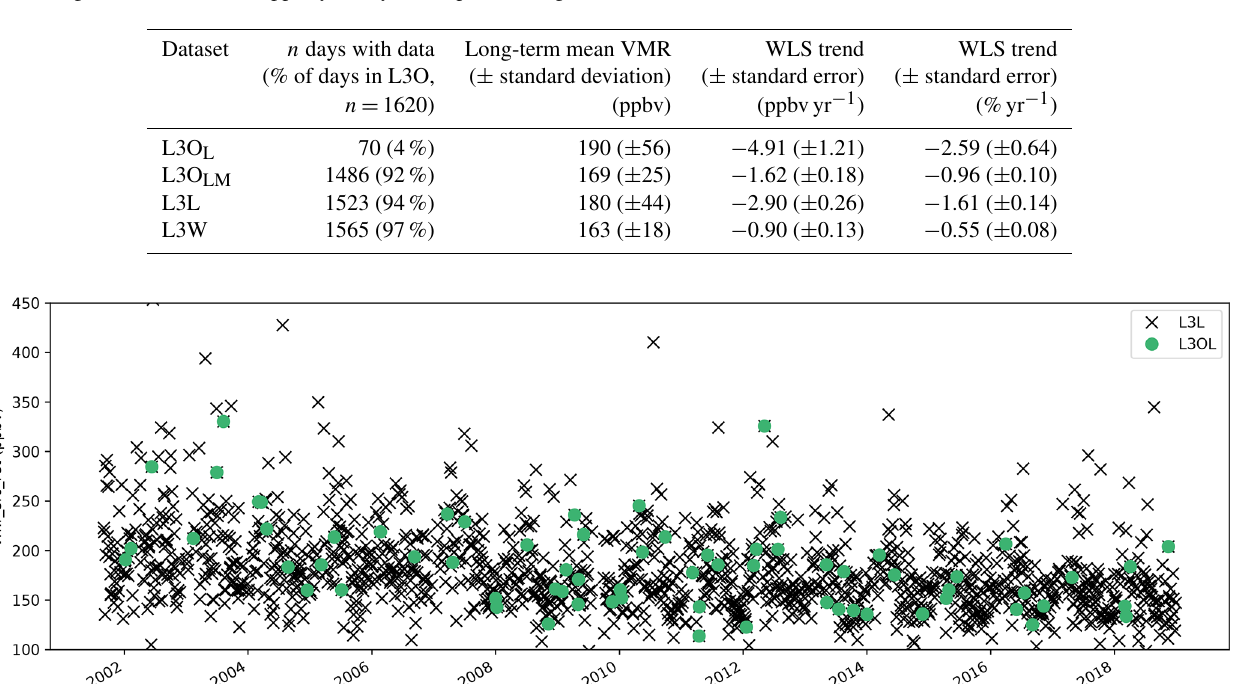
Table 6. Summary stats from L3O subsets compared, L3L, and L3W (for comparison), for the L3 grid box containing the city of Dubai. Note that across the whole study period (1 September 2001 to 31 December 2018), there are 5988 MOPITT files available. There is 1620d with data in the L3O dataset (unfiltered by surface index), 27% of the whole study period. The WLS trend in units of%yr − 1 is calculated by dividing the trend in units of ppbvyr − 1 by the respective long-term mean VMR value.